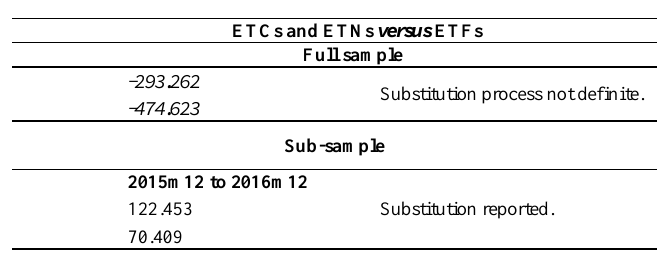
Table 4. Estimated substitution models for the turnover of exchange-traded products in